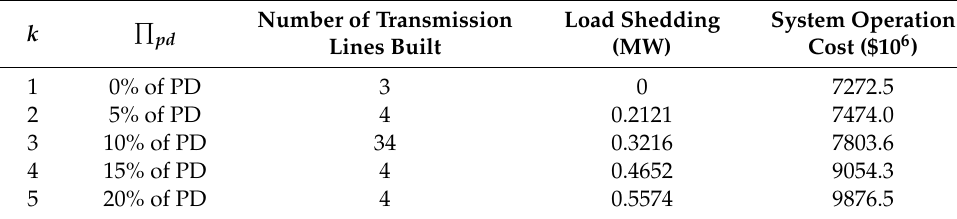
Table 6. IEEE 118-bus power system: Robust sole transmission